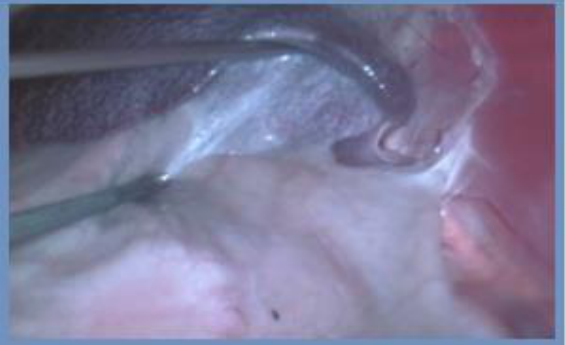
Figure, 2: The dissection between spleen and dorsal side of rumen.